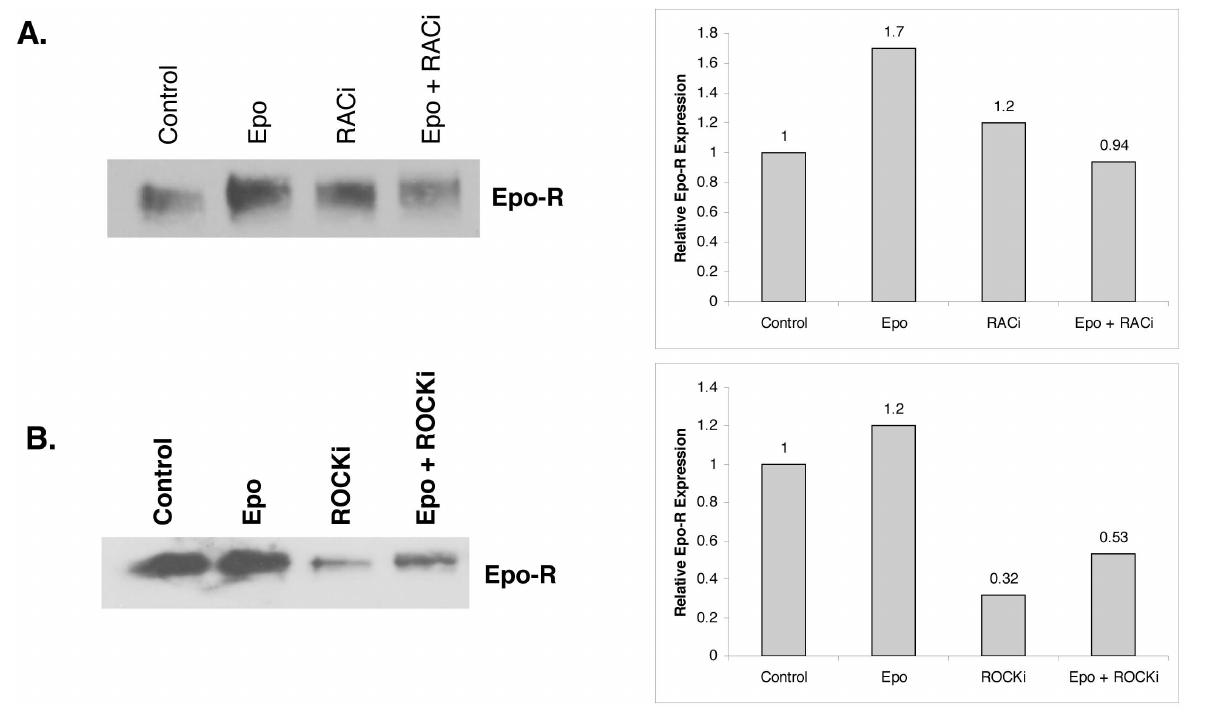
Figure 6. Recruitment of Epo-R into lipid rafts is dependent on Rac1 and RhoA GTPase activation. (A) Raft fractions were isolated from UT7 cells pretreated with 100 nM Rac1 inhibitor for 1 hr prior to Epo stimulation then immunoblotted for Epo-R with corresponding quantitation. (B) Raft fractions were isolated from UT7 cells pretreated with 100 uM ROCK inhibitor (Y-27632) for 1 h prior to Epo stimulation then immunoblotted for Epo-R with corresponding densitometry analysis. Westerns are representative of two independent experiments.